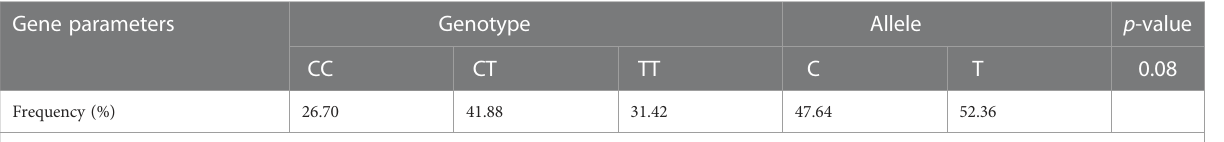
TABLE 1 Genotype frequencies according to C677T in patients. Gene